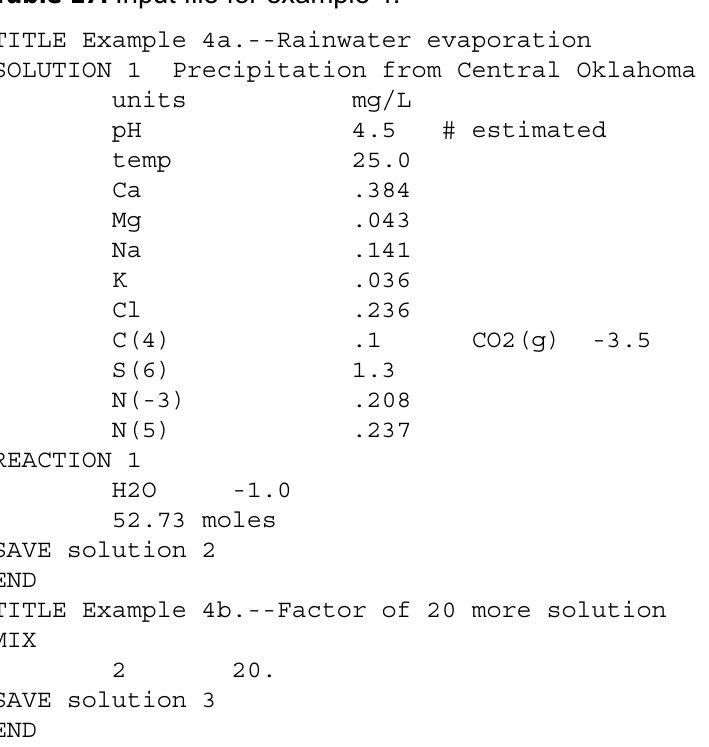
Table 17. Input file for example